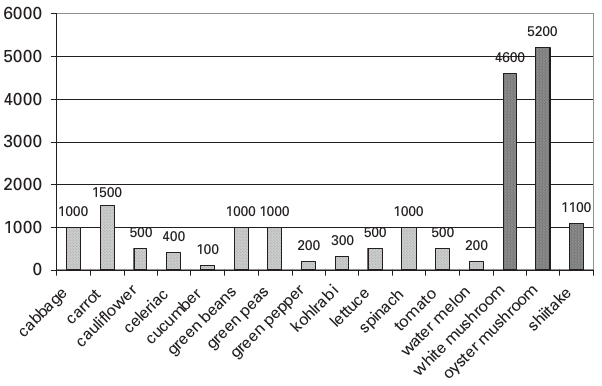
Figure 6. Average niacin content (µg) in 100 g vegetables and mushrooms